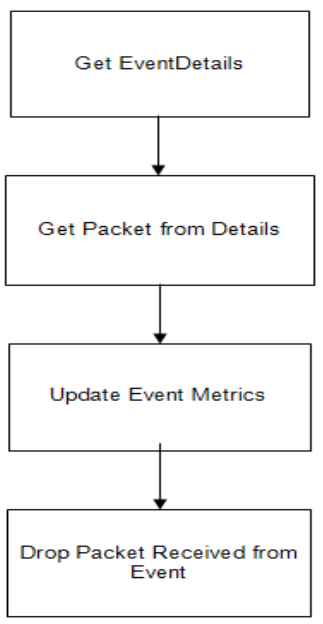
Figure 7. Malicious node dropping packets.